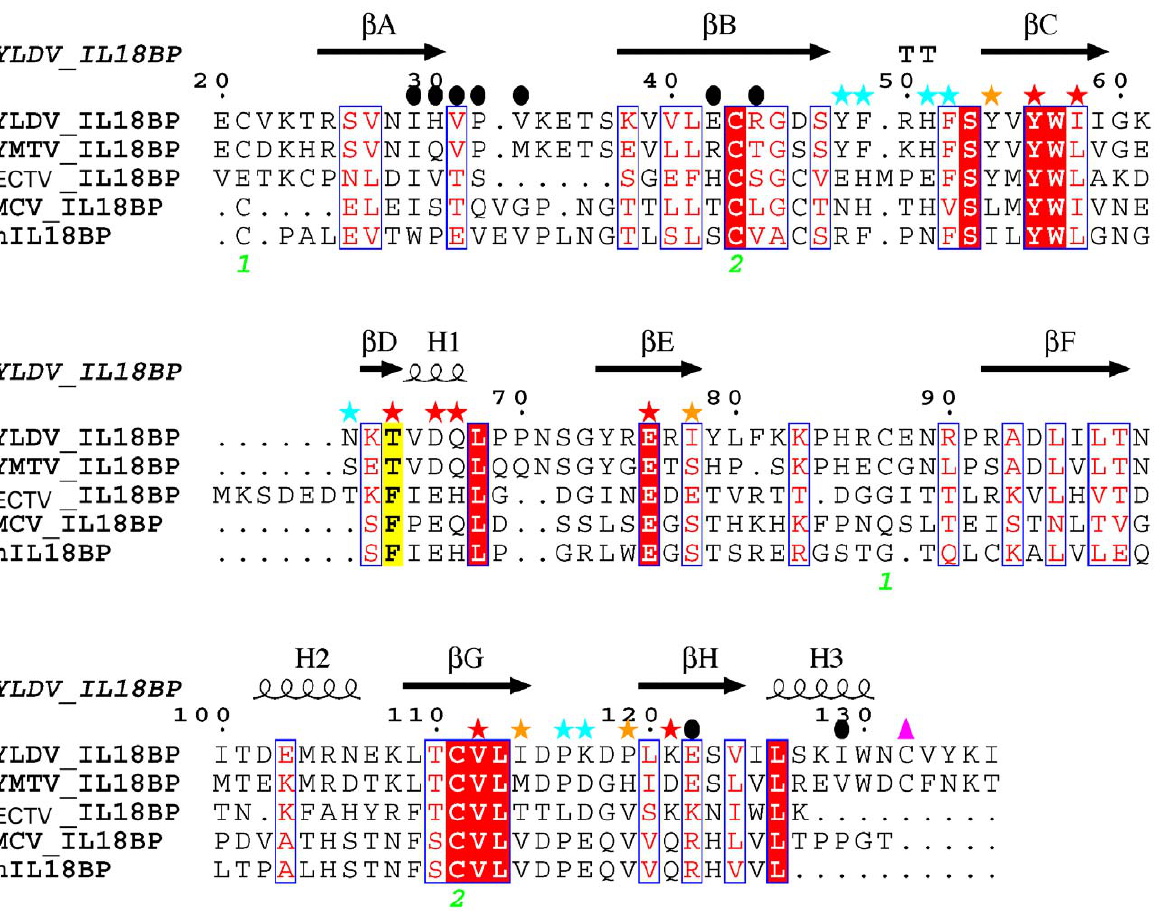
Figure 1. Structure based sequence alignment of IL18 binding proteins. Structure based sequence alignment of various IL18BPs was created using the crystal structure of YLDV-IL18BP as the template. Lettering and numbering above alignment correspond to YLDV-IL18BP topology and numbering scheme. Colored stars above residues indicate the three binding sites on IL18 with which they interact, red: site A, orange: site B, cyan: site C. Solid black circles above residues indicate resides involved in homo-dimerization. The two intra-chain disulfide bonds are indicated with the green letters. The cysteine residue forming the unique inter-chain disulfide bond is indicated with a pink triangle. The sequence alignment was performed with the FATCAT server [44] and ClustalX [45], and the figure was created with ESPript [46].